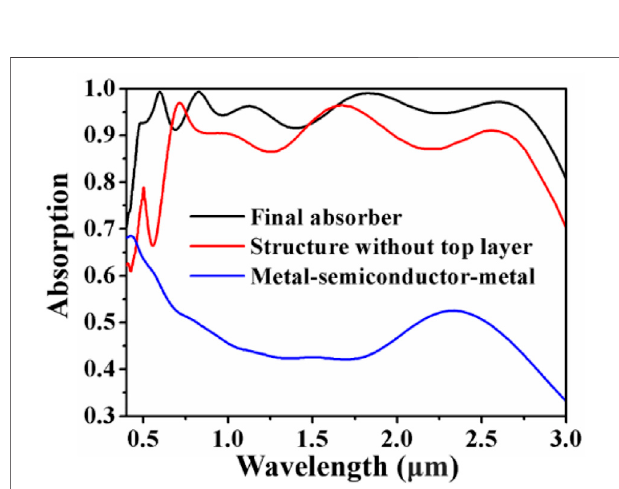
Frontiers in Materials |